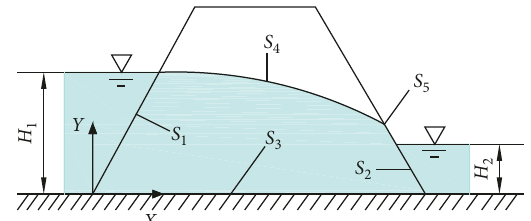
Figure 6: Typical seepage boundary conditions of an earth dam.